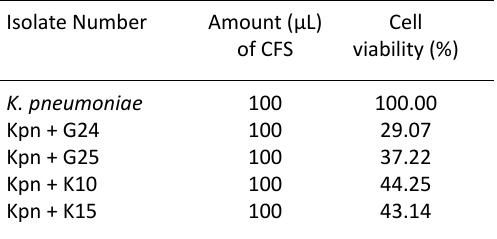
Table 5. Measurement of OD of K pneumoniae cell viability after incubation with Lactic acid bacteria ( p